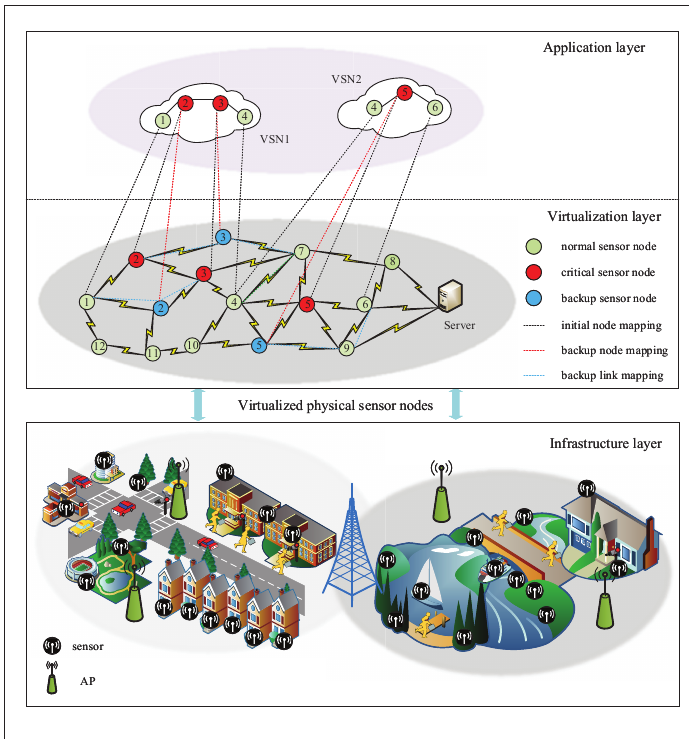
Figure 1. Virtualized wireless sensor network (WSN) survivable embedding model